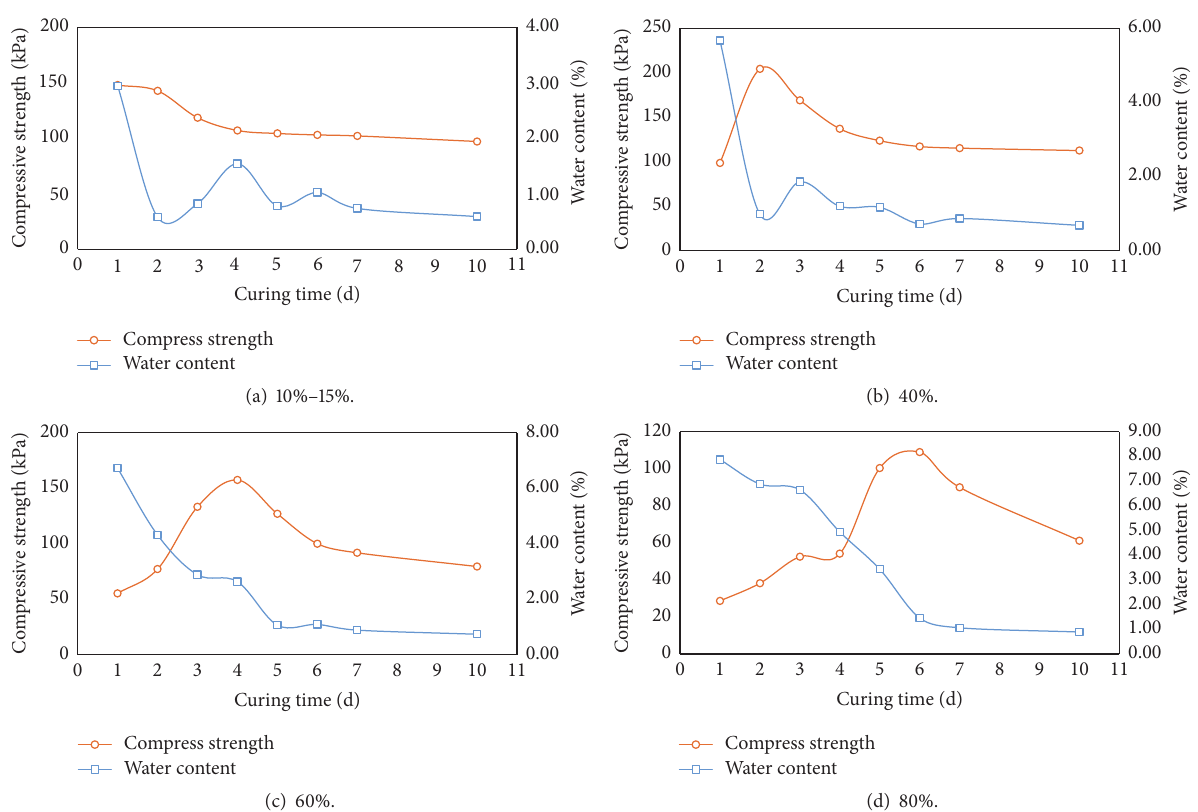
Figure 12: Variation regularity of water content, strength, and time under various curing